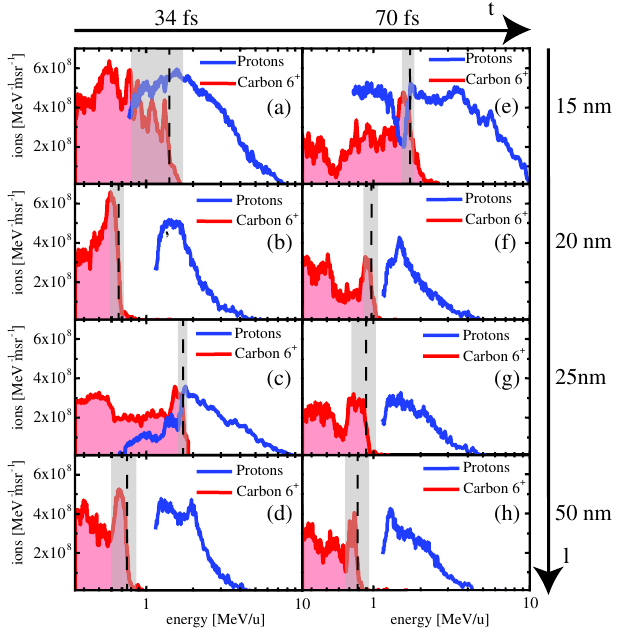
FIG. 1. Measured proton (blue) and C 6 þ (red) spectra gener- ated using circularly polarized laser pulses with durations 34 fs (a)–(d), 70 fs (e)–(h), and target thicknesses of ranging from l ¼ 15 nm to l ¼ 50 nm . To compare the velocities of the individual ion species, the energy scale is given in MeV per atomic mass unit u , the ion interface is indicated as the C 6 þ cutoff (black dashed line) with its standard deviation of three laser shots (grey area). The low energy cutoff of the proton spectra is due to the detector edge which was modified in the case of (a), (c), and (e) to resolve the low energy part of the proton